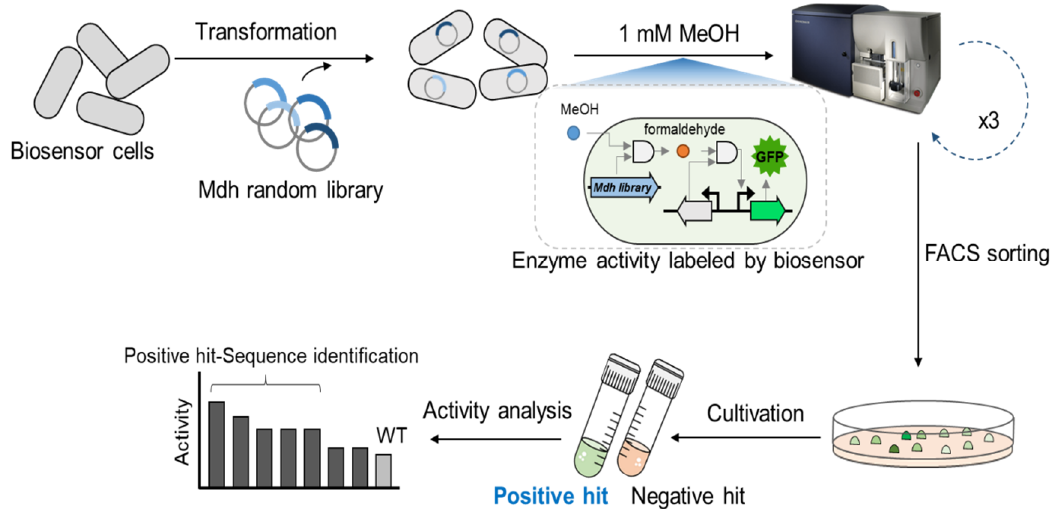
Figure 1. Schematic of the screening procedure for methanol dehydrogenase (Mdh) evolution using a formaldehyde-detectable transcription factor-based biosensor and random library.